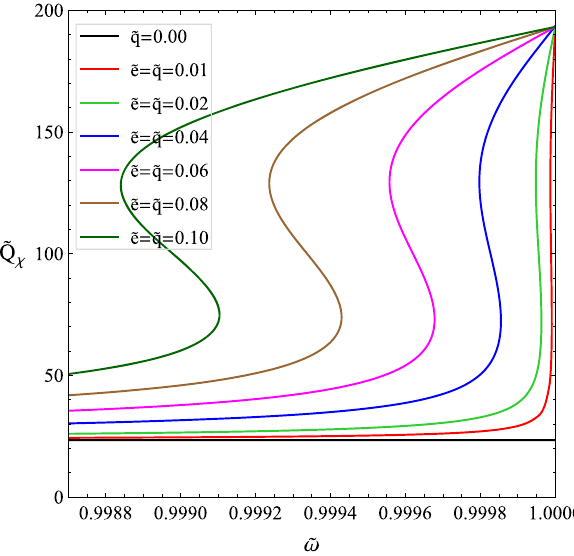
Fig. 2 Dependence of the Noether charge ˜ Q χ of the vortex-Q-ball systemonthedimensionlessphasefrequency ˜ ω inthevicinityof ˜ ω = 1. The parameters of the vortex-Q-ball system are the same as in Fig. 1